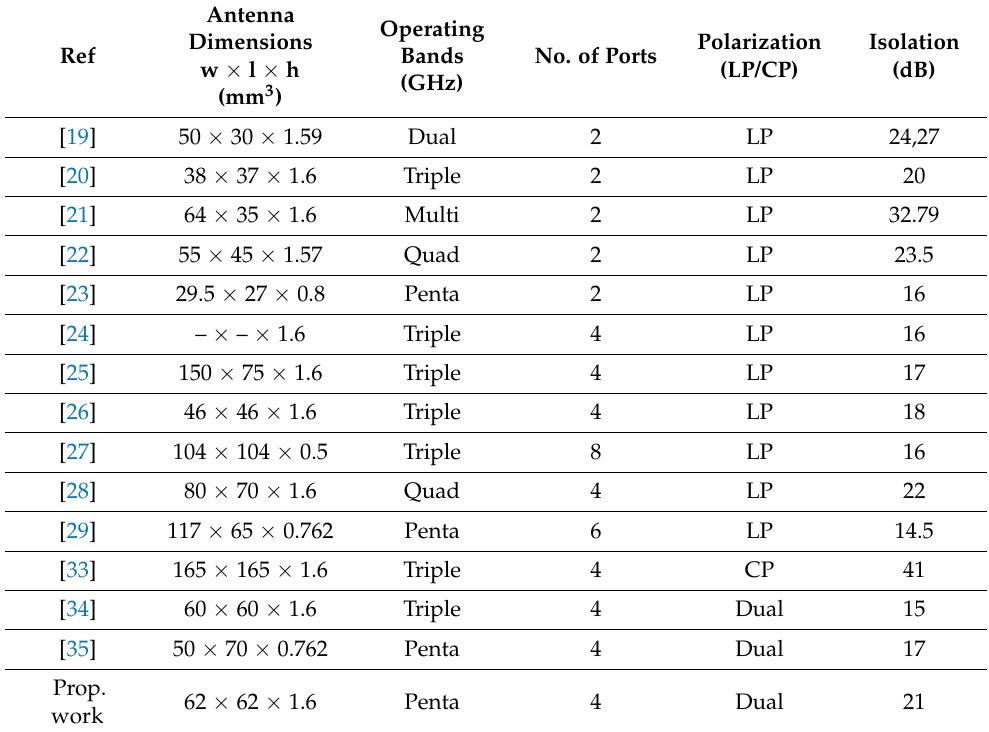
Table 1. Comparison of pentaband MIMO antenna with the antennas in the